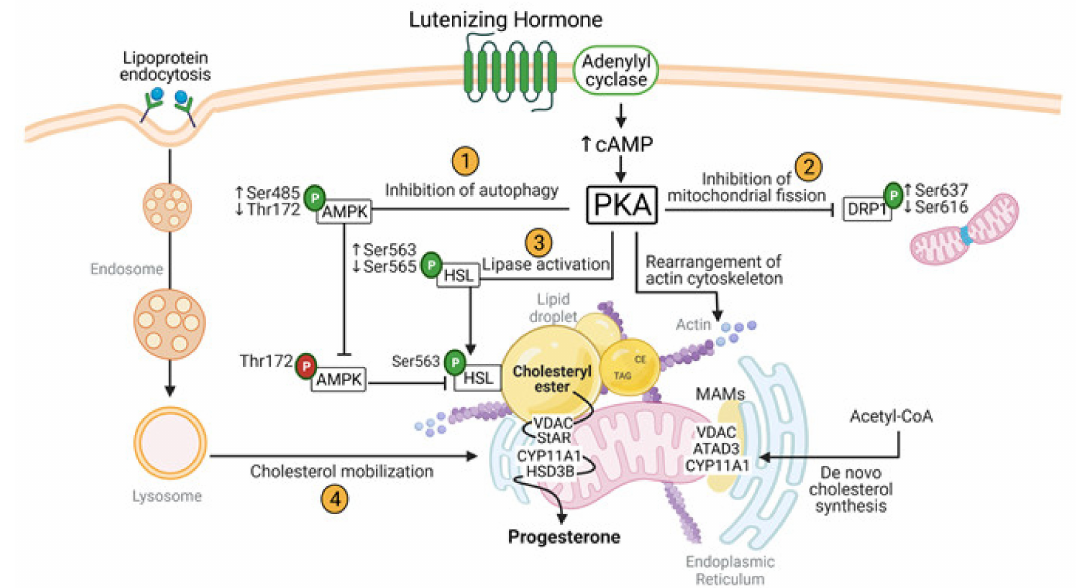
Figure 5. Cellular and metabolic changes induced by LH in steroidogenic luteal cells. Illustration of essential intracellular signals regulating inter-organelle communication provoked by LH/PKA signaling for optimal progesterone biosynthesis. Cyclic adenosine monophosphate (cAMP); protein kinase A (PKA); hormone sensitive lipase (HSL); steroidogenic acute regulatory protein (STAR); cholesterol side-chain cleavage enzyme (CYP11A1); 3 β -hydroxysteroid dehydrogenase (HSD3B); voltage- dependent anion channel (VDAC); AAA domain-containing protein 3 (ATAD3); 5 (cid:48) -AMP-activated protein kinase (AMPK); mitochondrial associated membranes (MAMs); triglyceride (TAG); cholesteryl ester (CE). Created with BioRender.com [209]. “P” in the green circle means phosphorylation site regulated by LH; “P” in the red circle means phosphorylation site required for AMPK activation. Up and down arrows mean increased and decreased phosphorylation,